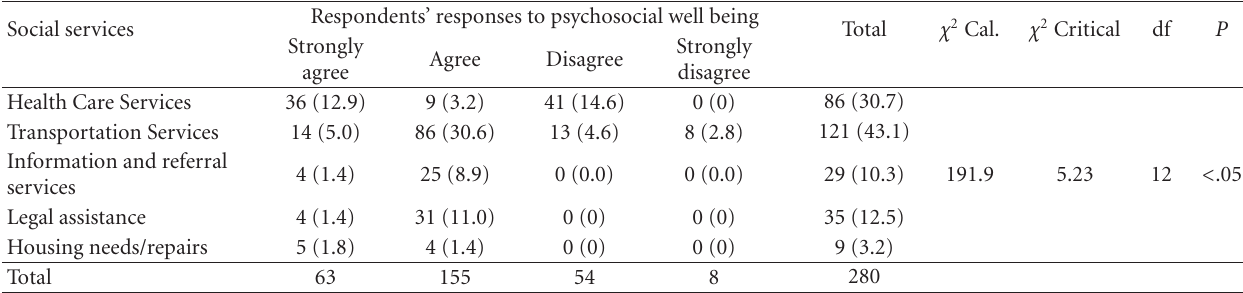
Table 2: Cross-tabulation and chi-square analysis of the social services and psychosocial well-being of elderly. Social services